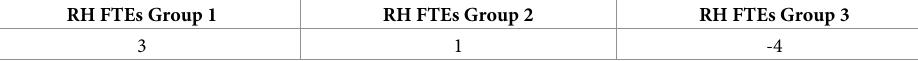
Table 3. Group inequity—Robin Hood (RH) Full-Time Equivalent (FTE) pathologists. RH FTEs Group 1